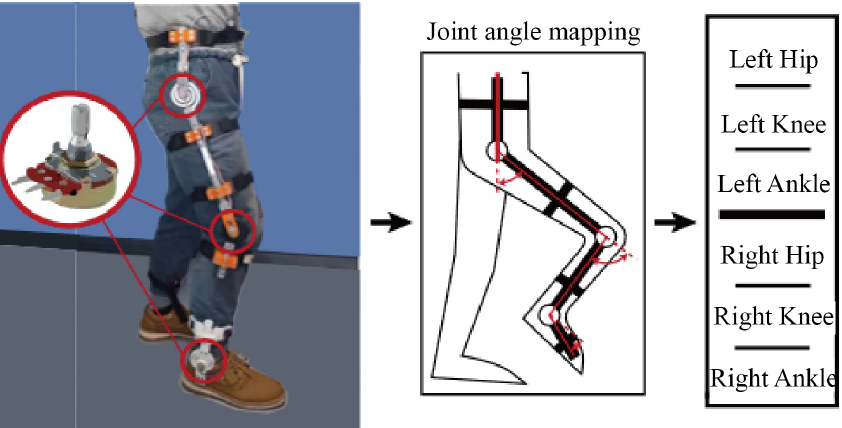
Figure 5. The wearable joint angle measurement device.